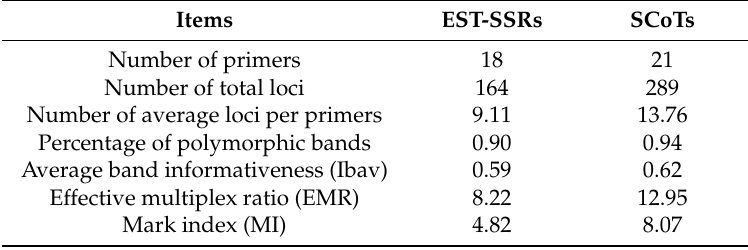
Table 1. Comparison of usefulness between EST-SSR and SCoT markers for 75 orchardgrass accessions.